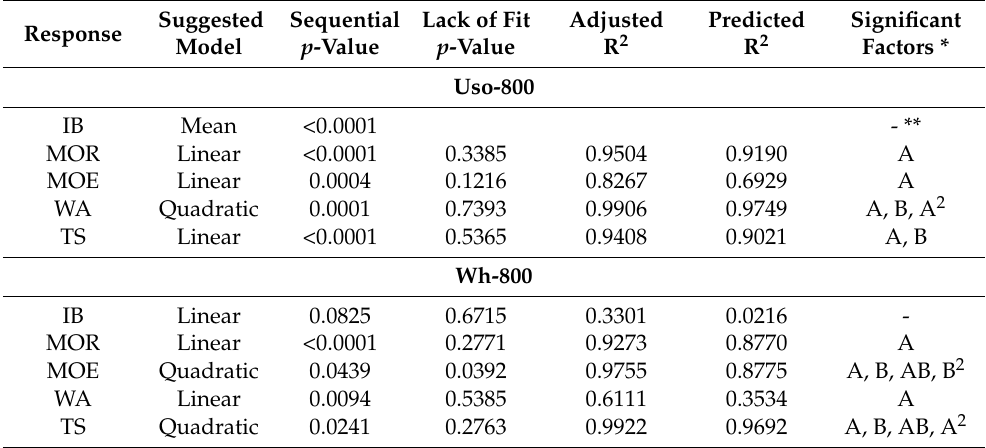
Table 2. Fit summary of the suggested models for each property of the boards with the density of 800 kg m − 3 . Suggested Sequential Lack of Fit Adjusted Predicted Significant Response p -Value p -Value Model R 2 Factors